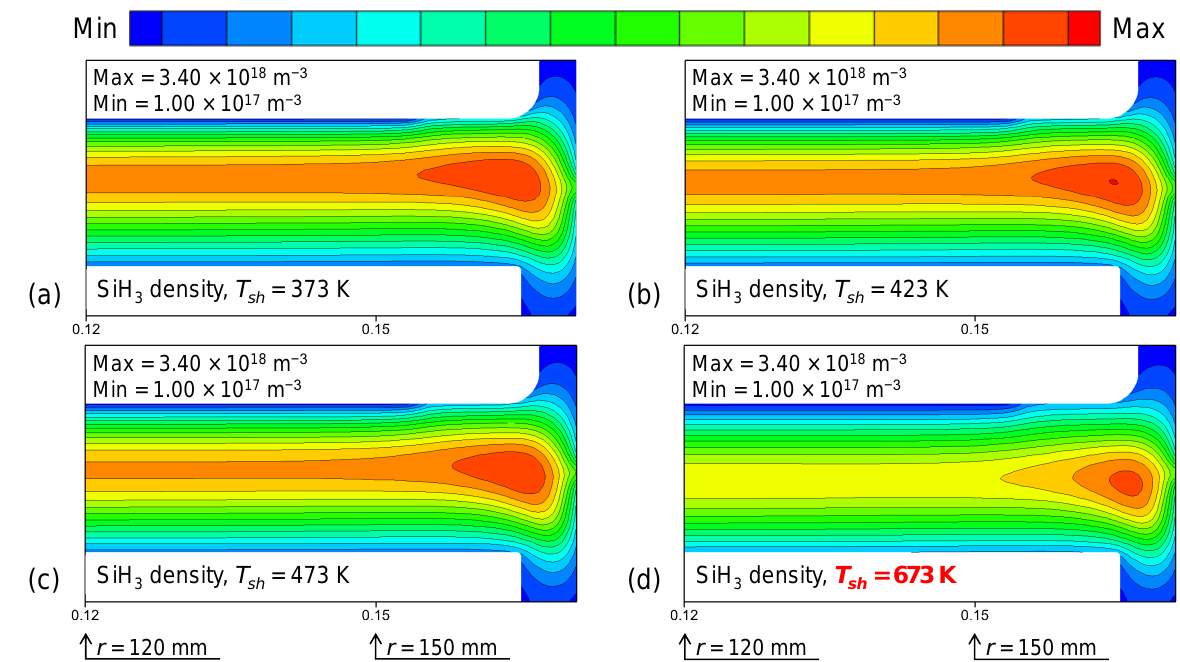
Figure 8. Effects of the showerhead temperature ( T sh ) on the spatial distribution of the radical. Spatial variations in the SiH 3 density distributions (m − 3 ) for ( a ) Case 2 ( T sh = 373 K), ( b ) Case 3 ( T sh = 423 K), ( c ) Case 4 ( T sh = 473 K), and ( d ) Case 5 ( T sh = 673 K) for r ≥ 120 mm. The profiles are radially uniform for r < 120 mm.